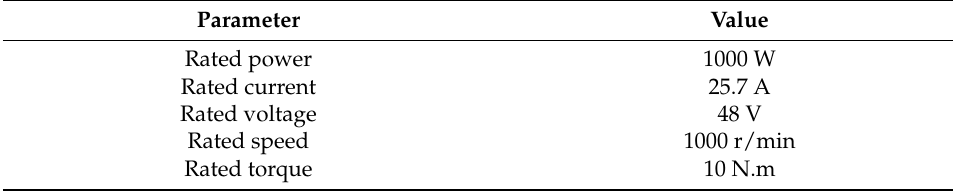
Table 5. Parameters of the PMSM.